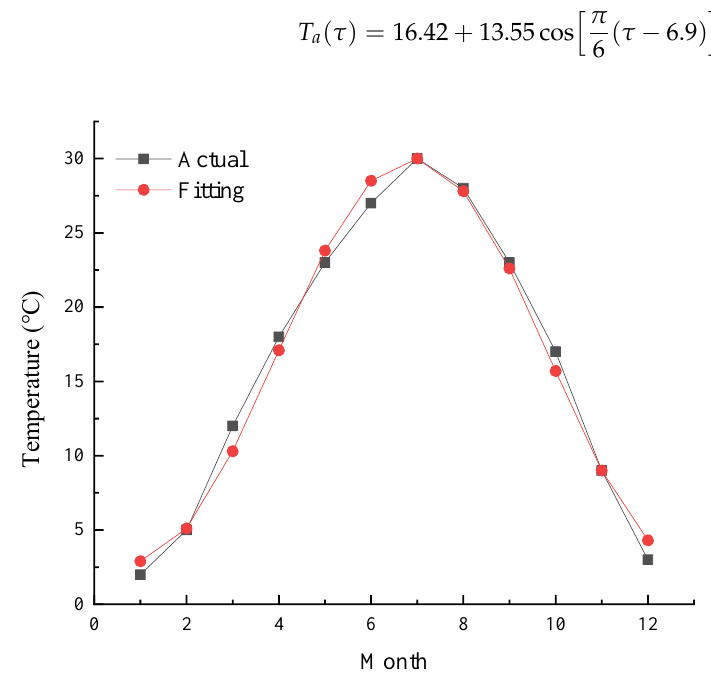
Figure 4. Comparison between the actual and fitting temperature.